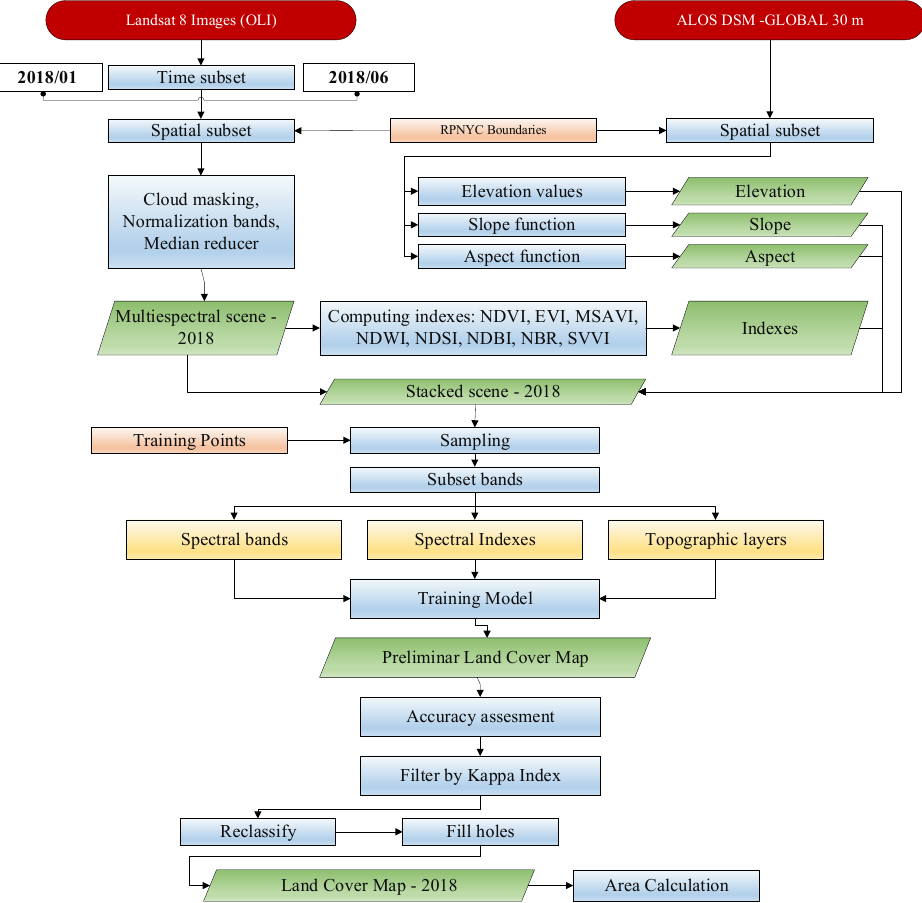
Figure 2. Representation of the methodological framework used in this study.